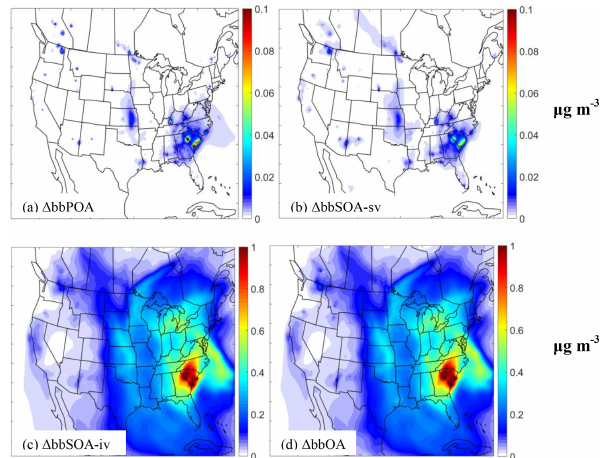
Figure 7. Average predicted increase (µgm − 3 ) of the predictions of the base PMCAMx-SR scheme when the molecular weights and aging stoichiometric coefficient of Ciarelli et al., 2017a, b) are used compared to the predictions with the default values for ground-level PM 2 . 5 (a) bbPOA, (b) bbSOA-sv, (c) bbSOA-iv, and (d) bbOA dur- ing April 2008. Positive values indicate that the PMCAMx-SR base scheme with the molecular weights or stoichiometric coefficients of Ciarelli et al. (2017a, b) predicts higher concentrations.